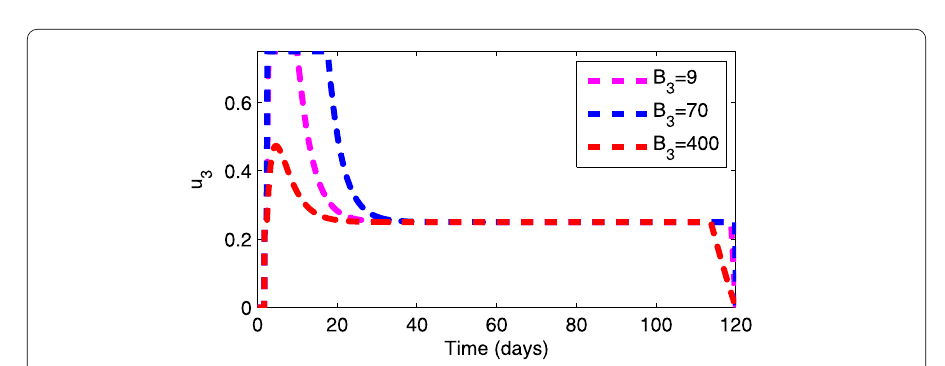
Figure 17 Plot of different weight constants on the control u 3